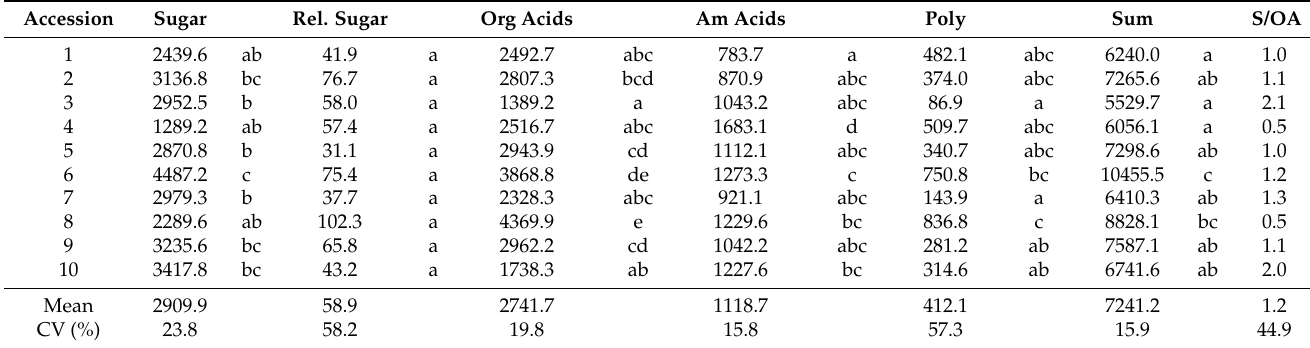
Values comprise the means of five repetitions. Different lowercase letters within a column indicate a significant difference at p < 0.05. Sugars comprise the sum of Scr, Fru, Glu; related sugars comprise the sum of Glc, Ins, Ado, Eth; amino acids represent the sum of Thr, Ala, Glut, Gln, Val, Leu, Ile, GABA, Cho, Glm, Asp; organic acids comprise the sum of Asc, MaA, Cit, Suc, QA, SHA, Gal; polyphenols comprise the sum of the aromatic spectrum region. Legend. S/OA: sugar/organic acid